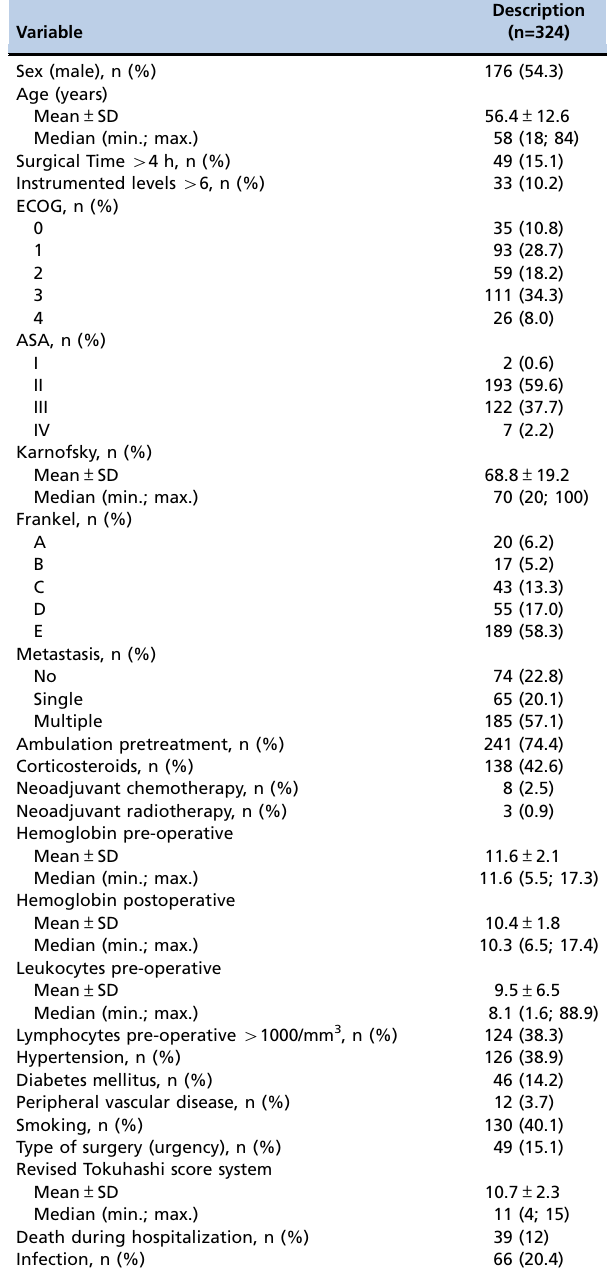
Table 1 - Distribution of the characteristics evaluated in all